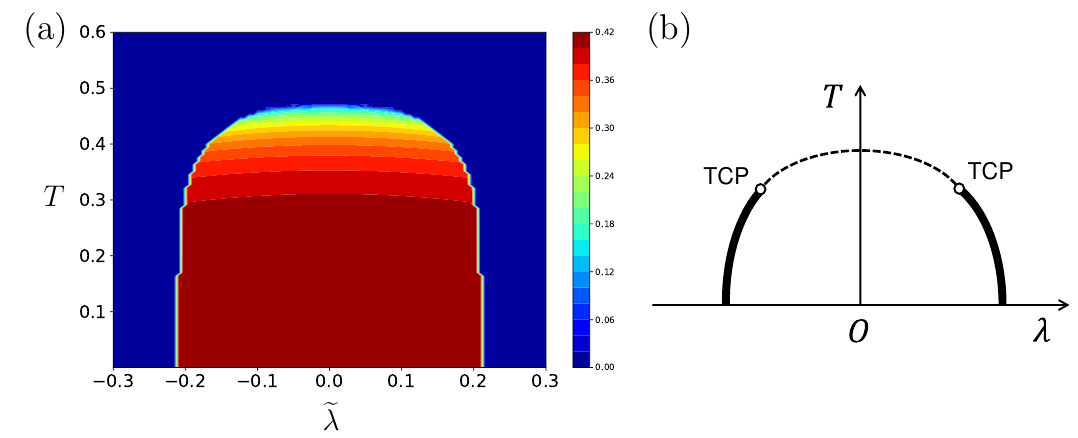
Figure 7 . (a) The phase diagram for M = 2 at µ = 0 with The magnitude of | e 1 − e 2 | is plotted. (b) A simplified sketch of (a). There are two tricritical points (TCP). The dashed line denotes a second-order transition and the thick solid line a first-order transition. We have omitted the high temperature phase diagram where a strip of first order phase transitions starts at about T = 1 . 5 and e λ = 6 . 2